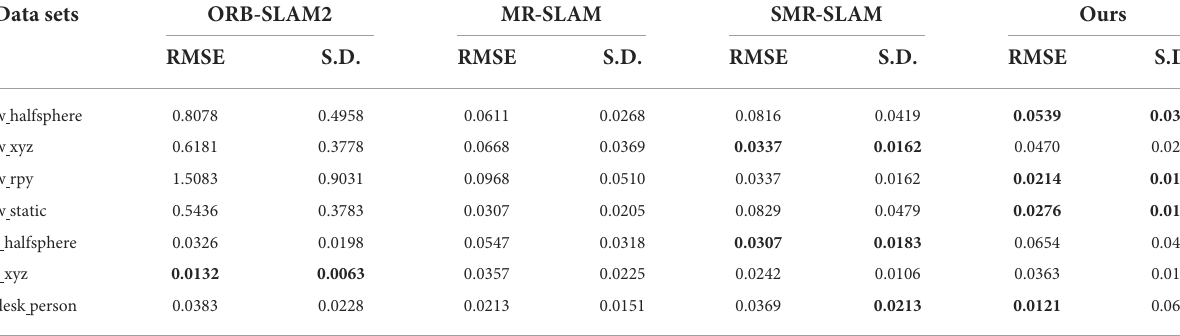
TABLE 3 Translational drift (RPE) in m/s for the experiments using ORB-SLAM2, MR-SLAM, SMR-SLAM, and Ours. Data sets